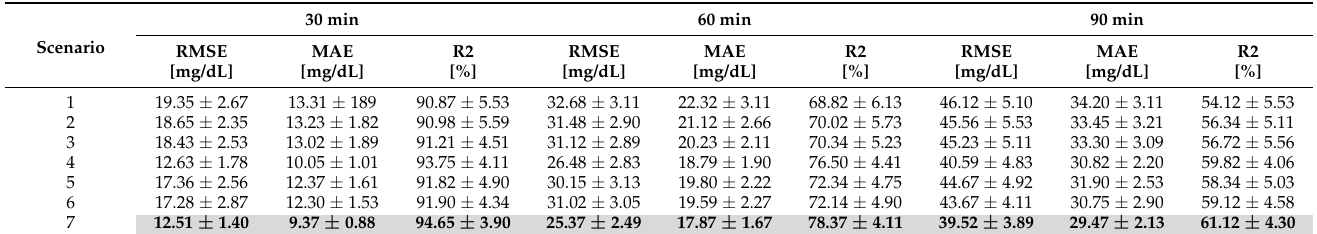
Table 3. Population results for CNN-LSTM model. RMSE [mg/dL], MAE [mg/dL] and R2 [%] for 30, 60 and 90 min ahead BG prediction, for different scenarios.